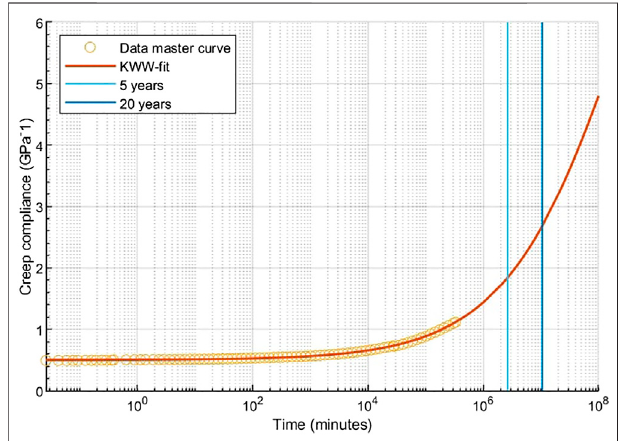
FIGURE13| Long-term creepcompliancemastercurveofunaged PSU with a KWW fi t on a log scale. The blue lines represent the time after 5 and 20